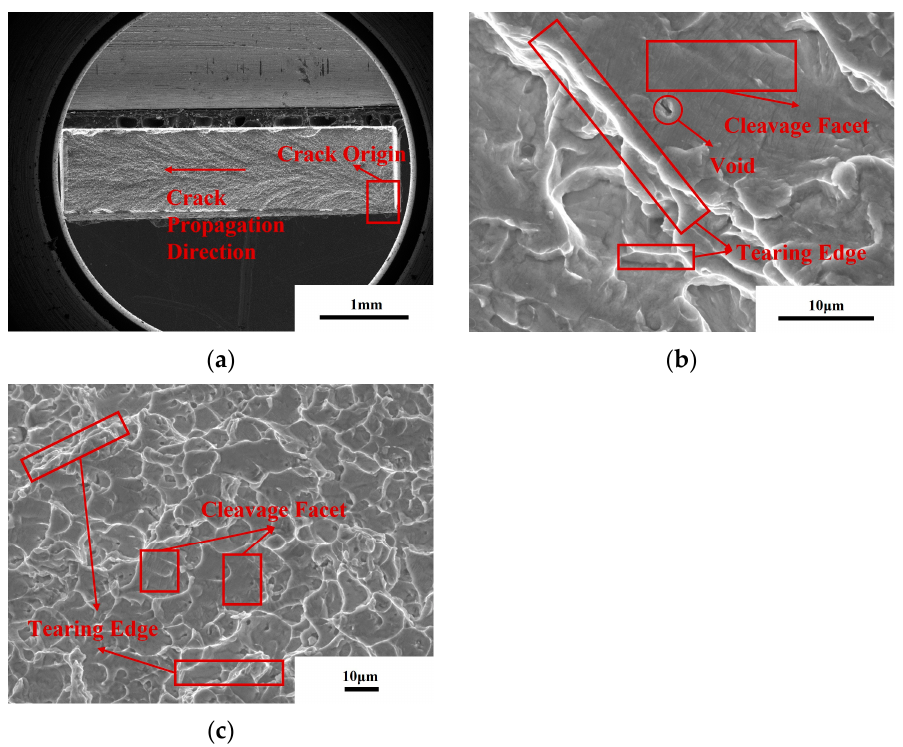
Figure 10. Fracture morphology after tensile test of alloy annealed at 400 °C for 60 min. ( a ) Low magni fi cation morphology of fracture area; ( b ) crack propagation area; and ( c ) dimple region.